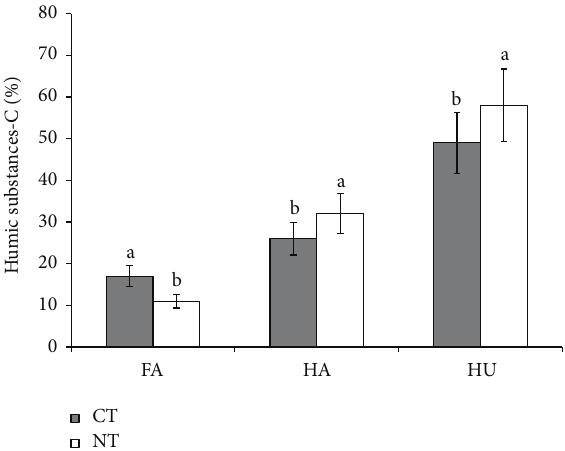
Figure 3: Humic substances in Vertisol under NT and CT (FA: fulvic acid; HA: humic acid; HU: humin), for each of the substances (treatments with the same letter are not significantly different (Student’s t -test with 𝑃 < 0.05